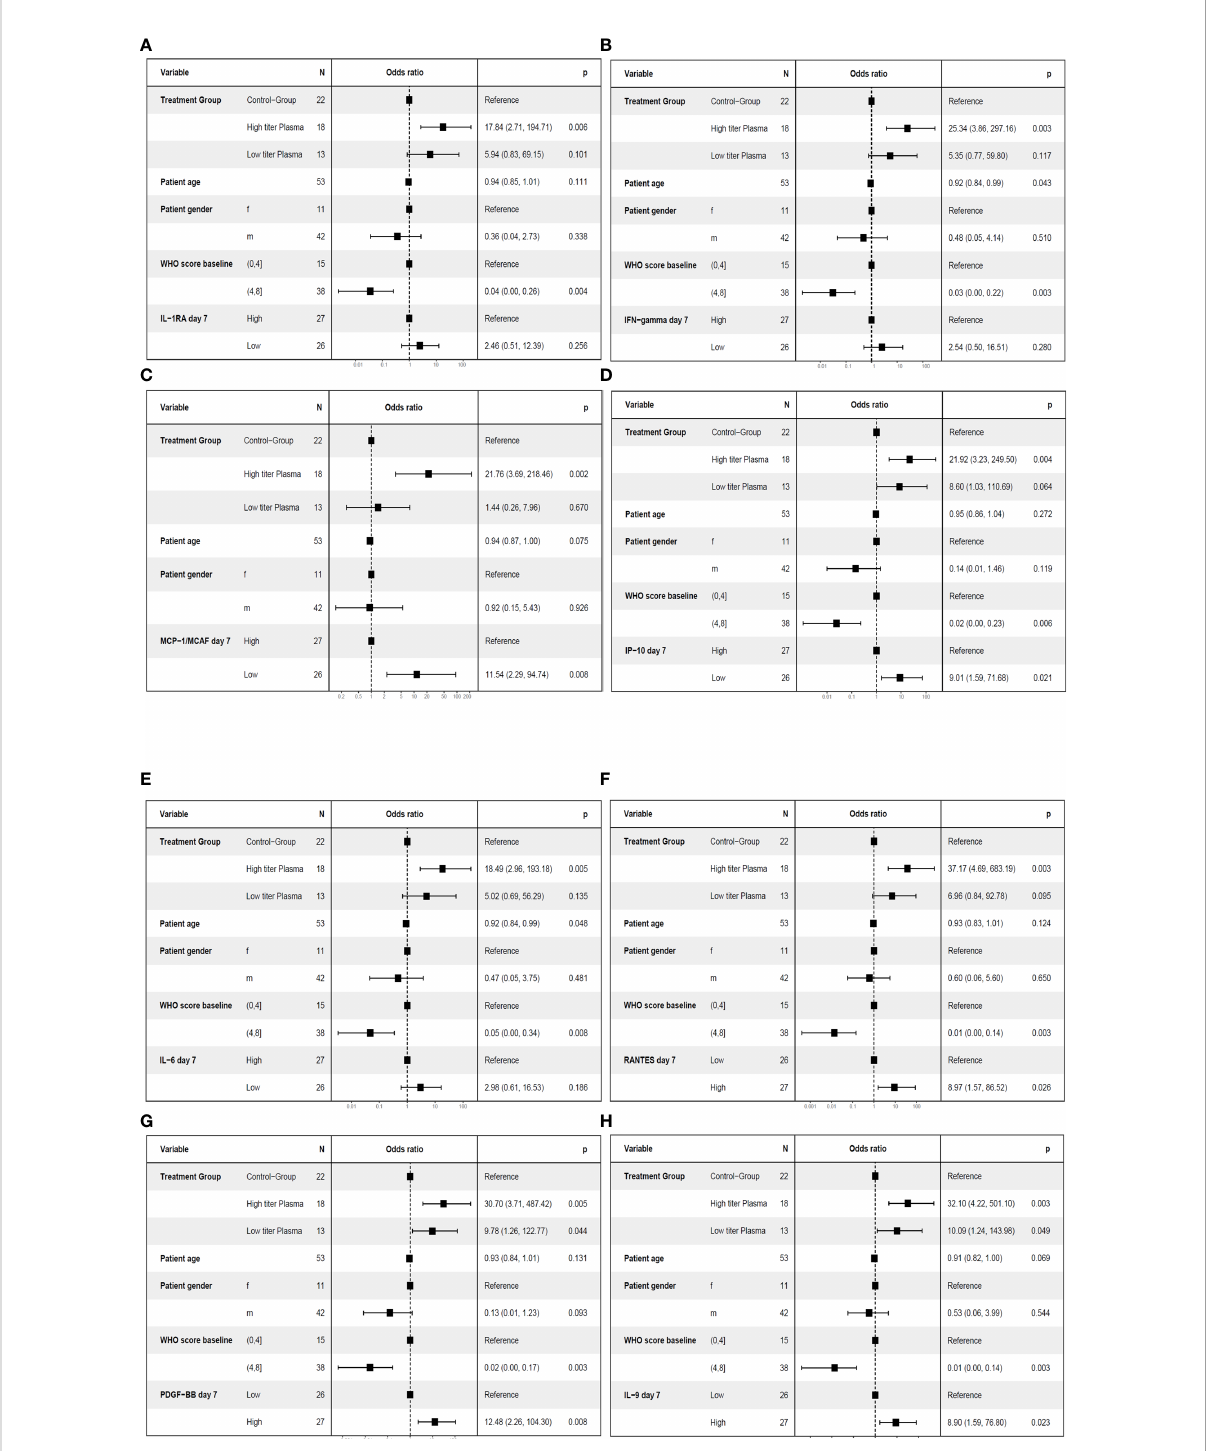
FIGURE 8 Multivariate analyses of primary endpoint (survival and no longer meeting criteria for severe COVID-19 on day 21) including cytokine levels on day 7. The following variable were included in the model: Treatment group (control group, high titer plasma, low titer plasma), age (as continuous variable), gender, baseline WHO Severity Score ( ≤ 4 vs. > 4) (11) and the level of the respective cytokine on day 7 ( ≤ median ( “ low ” ) versus > median ( “ high ” )). One cytokine each was included in the models: IL-1RA (A) , IFN- g (B) , MCP-1 (C) , IP-10 (D) , IL-6 (E) , RANTES (F) , PDGF- BB (G) or IL-9 (H)